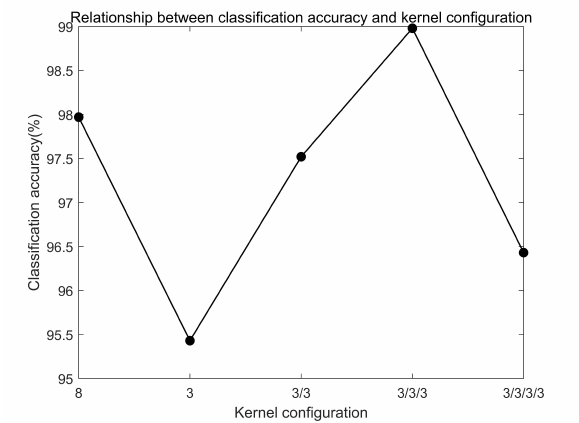
Figure 10. Relationship between classification accuracy and kernel configuration.